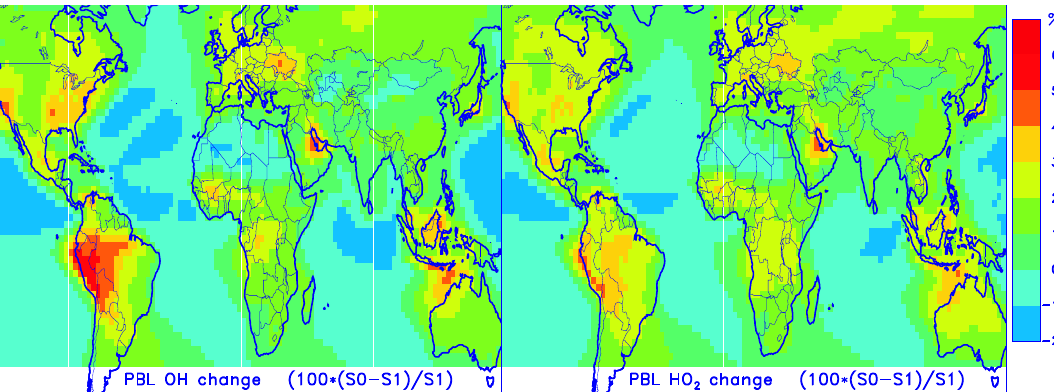
Fig. 2. Calculated percentage change in OH (left) and HO 2 (right) concentrations below 1.5km altitude in July 2005 due to the inclusion of the OH-forming channel in specific RO 2 +HO 2 reactions.